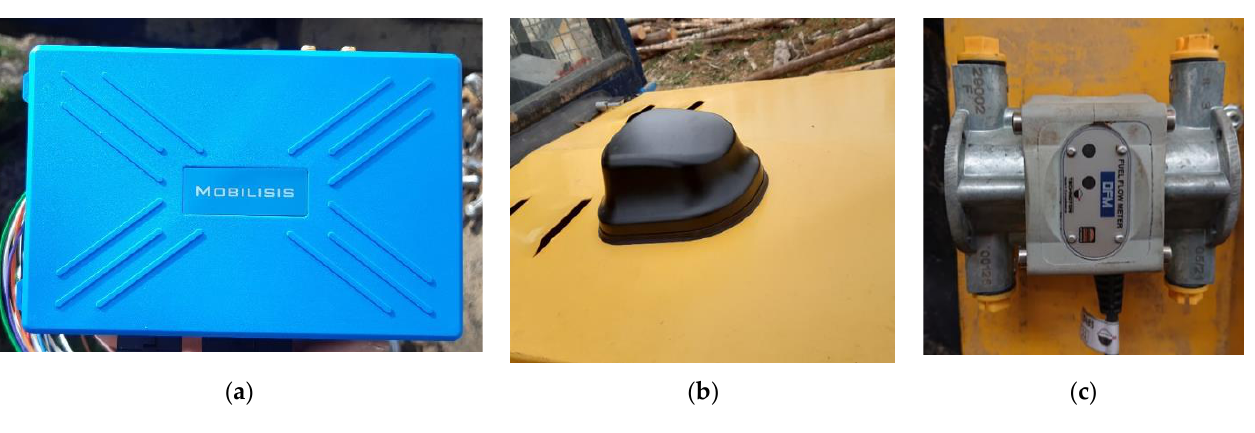
Figure 1. Fleet management components that are installed on the skidder. ( a ) WIGO-E (Telematic Data Collector), ( b ) GPS/GSM antenna, ( c ) differential fuel consumption meter — DFM 100CD.